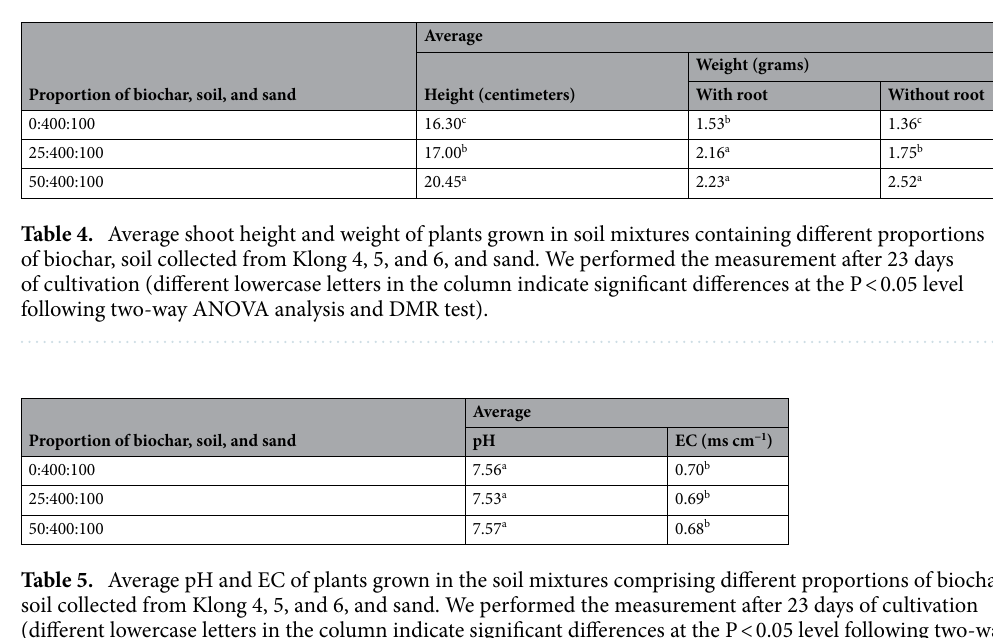
Comparing the average height of the plants grown in the soil mixtures comprising different proportions of biochar, soil, and sand, we found that plants grown in different soil mixtures were significantly different in height (P < 0.05). The average height of plants grown in the soil mixture containing 50 of biochar, 400 g of soil, and 100 g of sand was the greatest, at 20.45 cm, while that of the plants grown in the control soil mixture containing 0 g of biochar, 400 g of soil, and100 g of sand was the lowest, at 16.30 cm (P < 0.05) (Table 4 and Supplementary Fig. 2). The average plant weight with root was not significantly different between the plants grown in the soil mixture comprising 25 g of biochar, 400 g of soil, and 100 g of sand, and that comprising 50 g of biochar, 400 g of soil, and 100 g of sand (P > 0.05). The average weight of the plants with roots grown in the soil mixture comprising 50 g of biochar, 400 g of soil, and 100 g of sand was the greatest, at 2.23 g, while that of the plants grown in the control soil mixture comprising 0 g of biochar, 400 g of soil, and 100 g of sand was the lowest, at 1.53 g (P > 0.05) (Table 4). The average plant weight without root was significantly different among the plants grown in the soil mixtures comprising different proportion of biochar, soil, and sand (P < 0.05). The average weight of plants grown in the soil mixture comprising 50 g of biochar, 400 g of soil, and 100 g of sand was the greatest, at 2.52 g, while that of the plants grown in the control soil mixture comprising 0 g of biochar, 400 g of soil, and 100 g of sand was the lowest, at 1.36 g (P < 0.05) (Table 4). When we determined the average pH of the soil mixtures containing different proportions of biochar, soil collected from Klong 4, Kong 5, and Klong 6, and sand after the cultivation of water convolvulus, we found no significant differences in the average pH of the soil mixtures (P > 0.05). The average pH of the soil mixture comprising 0 g of biochar, 400 g of soil, and 100 g of sand was 7.56. That of the soil mixture comprising 25 g of biochar, 400 g of soil, and 100 g of sand was 7.53, and that of the soil mixture comprising 50 g of biochar, 400 g of soil, and 100 g of sand was 7.57 (P > 0.05) (Table 5). The average EC was not significantly different among the soil mixtures (P > 0.05). The average EC of the soil mixture comprising 0 g of biochar, 400 g of soil, and 100 g of sand was 0.70 ms cm −1 . That of the soil mixture comprising 25 g of biochar, 400 g of soil, and 100 g of sand was 0.69 ms cm −1 , and that of the soil mixture comprising 50 g of biochar, 400 g of soil, and 100 g of sand was 0.68 ms cm −1 (P > 0.05) (Table 5).